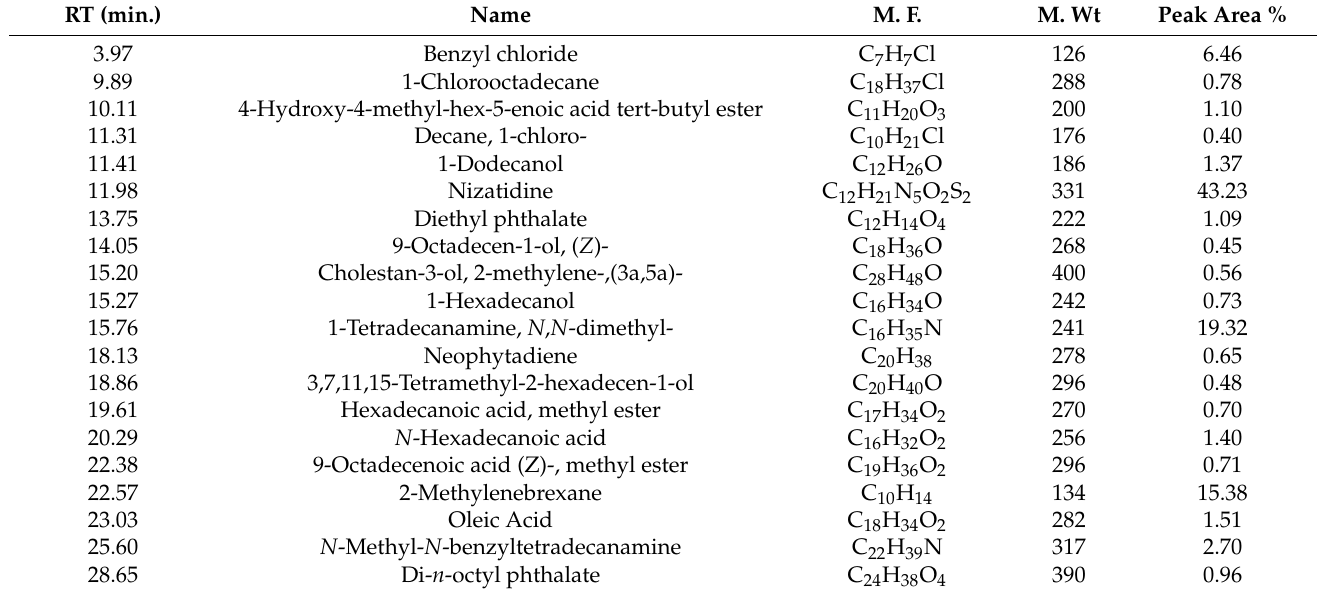
Table 2. GC-MS analysis of Musa sp. leaves extract (MLE).